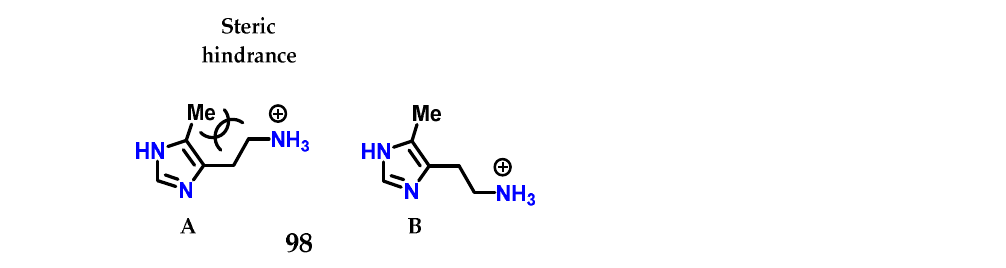
19 of 28 Figure 38. SAR for histamine H 1 and H 2 receptor agonists. Based on this information, it appears that the terminal amino group being protonated is involved in an ionic interaction with both types of receptors, while the nitrogen atoms of the heteroaromatic ring are linked through hydrogen bonds, and for H 2 receptors, the ring participates in an extra interaction through proton transfer (Figure 39) [125]. Figure 39. Scheme of the spatial arrangement for the interaction of histamine 8 on the H 1 and H 2 receptors. Checking the changes in the structure of histamine 8 , it was noted that 4(5)- methylhistamine 98 is a highly selective H 2 receptor agonist, showing greater selectivity for H 2 than for H 1 [125,126]. 4(5)-Methylhistamine 98 , similar to histamine 8 , is a highly flexible molecule due to its side chain, but structural studies show that some of their con- formations are less stable than others (Figure 40) [125,126]. In particular, conformation ( A ) is disadvantaged due to the steric interaction between the methyl group and the side ethylamine chain. The selectivity observed suggests that, for both receptors, 4(5)-